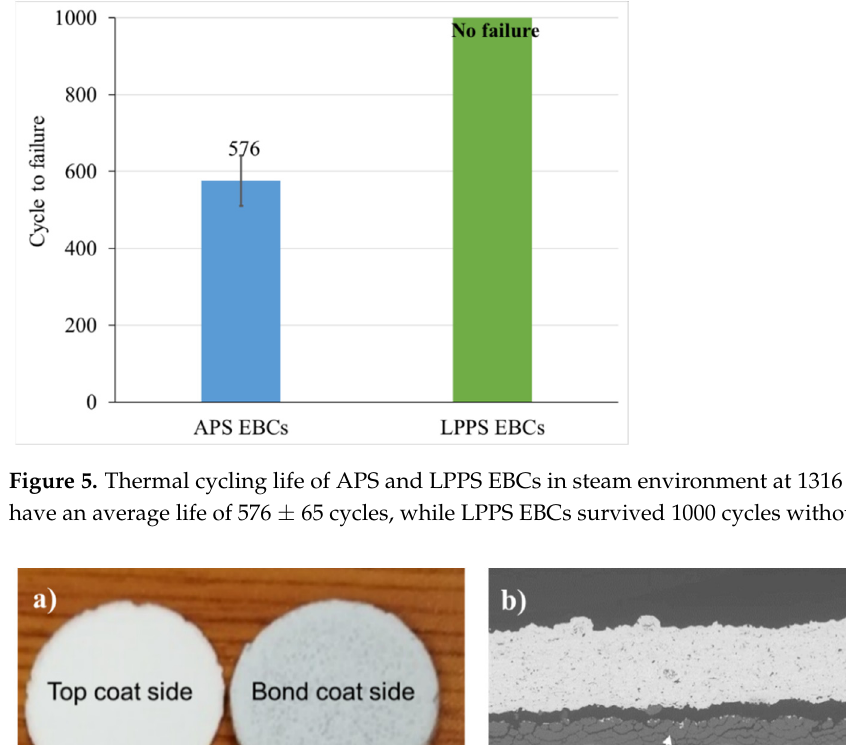
Figure 5. Thermal cycling life of APS and LPPS EBCs in steam environment at 1316 °C. APS EBCs have an average life of 576 ± 65 cycles, while LPPS EBCs survived 1000 cycles without failure.